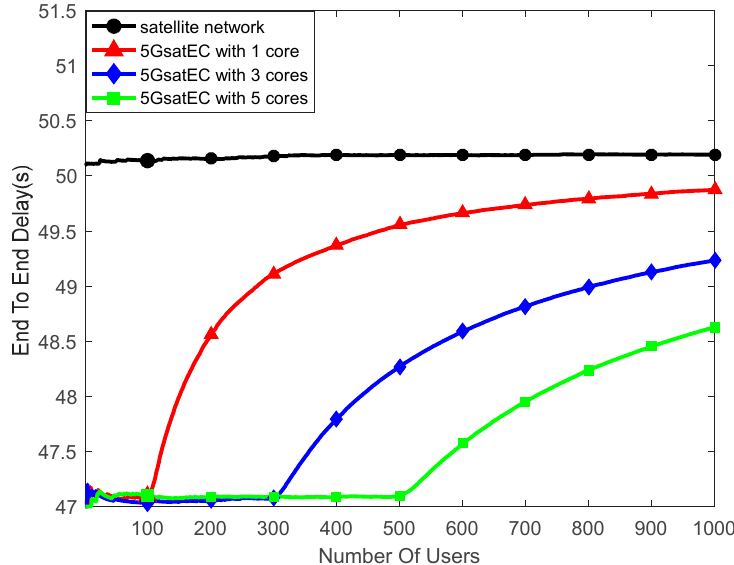
Figure 8. Delay between the satellite network and 5GsatEC with no storage.